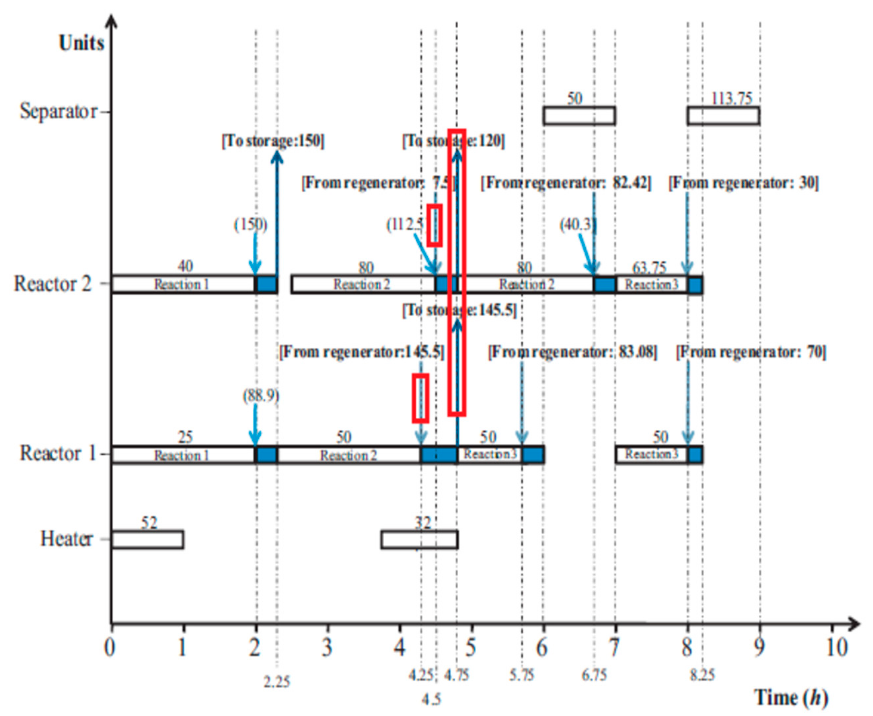
Figure 14. Reported Gantt chart from Adekola and Majozi [11] with mass balance violation shown in red box.